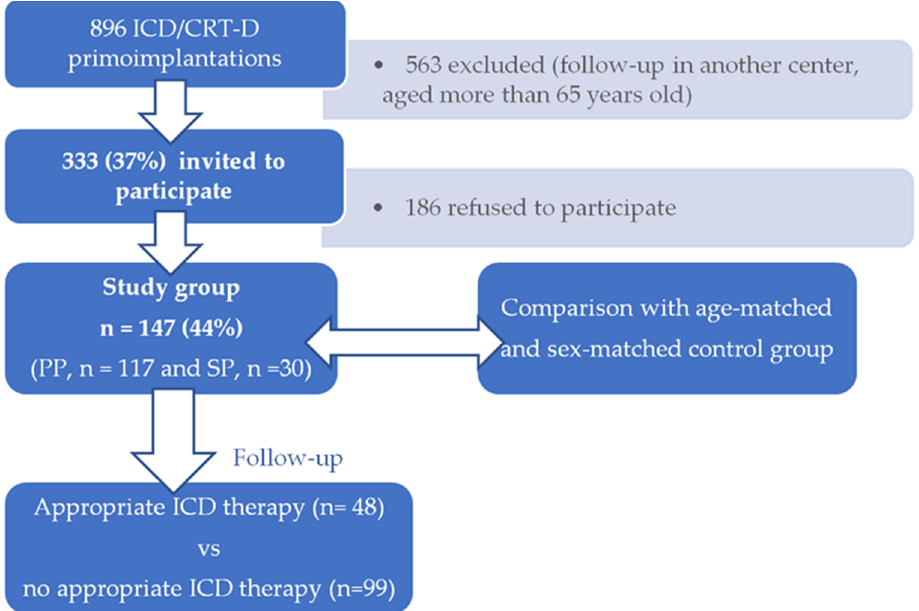
Figure 1. Study schema: A total of 896 patients underwent ICD/CRT-D primo-implantation between 1 January 2010 and 31 December 2014 at the Department of Internal Medicine I—Cardiology, Olomouc University Hospital, Czech Republic, 333 of whom were invited to participate. Only 147 of them agreed with enrolment, filled out the questionnaire (44% response rate) and were compared with age-matched and sex-matched control group (without high risk of SCD and ICD implantation) to evaluate whether the lifestyle and psychosocial factors could affect the probability of being at high risk of SCD. Then, they were followed up until 31 January 2020 when the effect of lifestyle and psychosocial factors on the occurrence of the adequate ICD therapy was assessed.